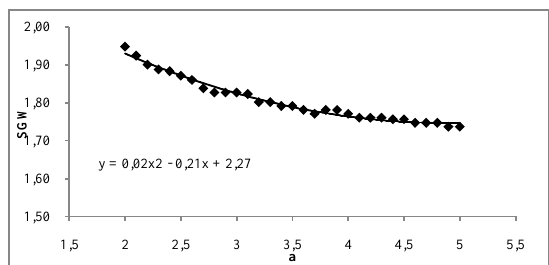
Fig. 26. Chart of S GW parameter and Blackman function parameter.